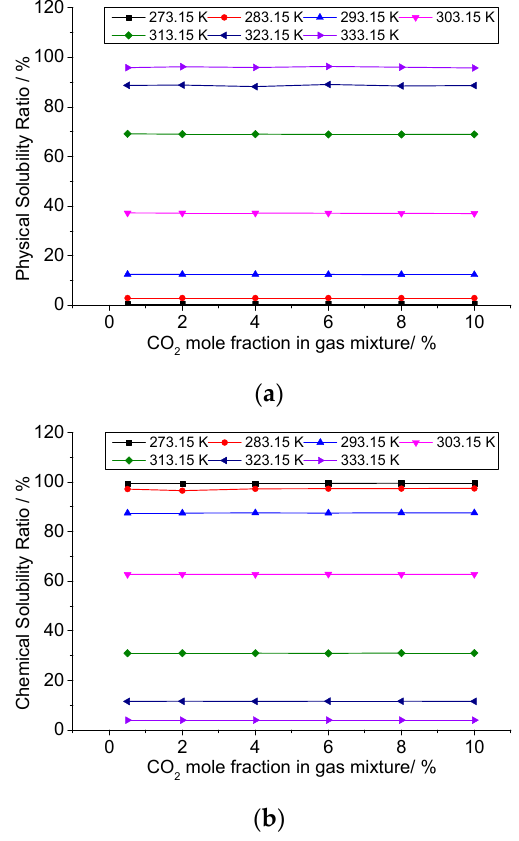
Figure 18. Percentage change curve of physical and chemical solubility. ( a ) 6.0 MPa physical solubility; ( b ) 6.0 MPa chemical solubility.